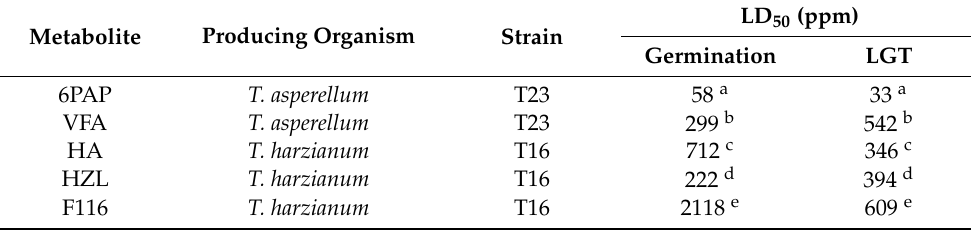
Figure 3. Suppression of urediospore germination ( a ) and germ tube elongation ( b ) of P. pachyrhizi in the presence of different concentrations of various SMs purified from Trichoderma strains T16 and T23. Urediospores were mixed with SMs to get a series of final concentrations ranging from 50 to 300 mg L − 1 . Mixtures were incubated on microscope slides at 25 °C in the dark for 6 h. Presented data are means of three replicates ± standard error (SE). Table 1. Doses generating 50% inhibition (LD 50 ) of urediospore germination and length of germ tube (LGT) of P. pachyrhizi after 6 h of exposure to secondary metabolites of Trichoderma spp. at 25 °C under ≥ 95% relative humidity (RH) and complete darkness. LD 50 values are means of two independent assays.